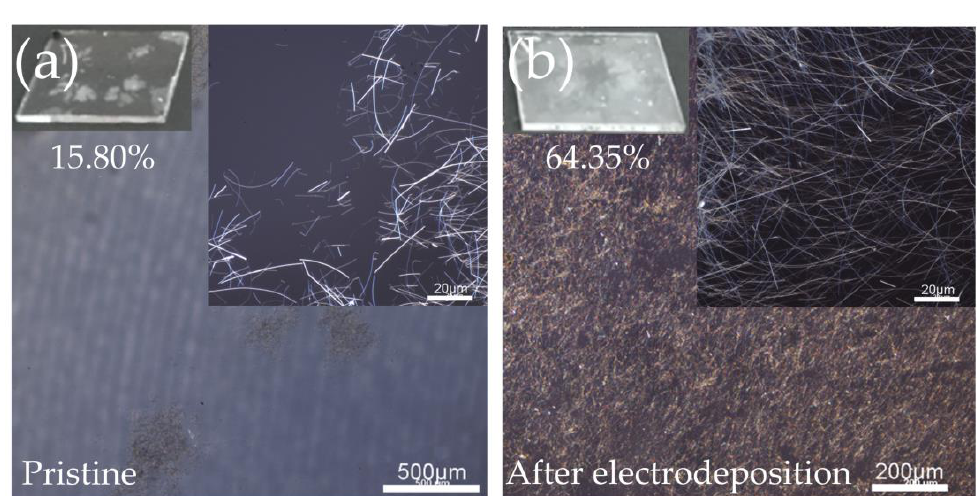
Figure 8. CLSM images of the films after ultrasonic treatment for 5 min: ( a ) pure AgNWs and ( b ) AgNW – Al 2 O 3 composite film. AgNW–Al 2 O 3 composite